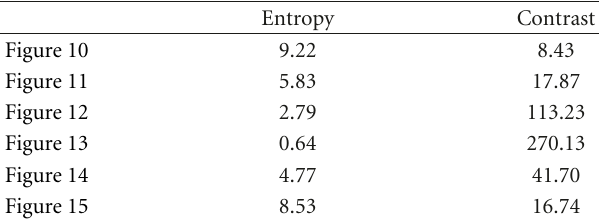
Table 4: Focusing indicators for the ISAR images corresponding to the real data.